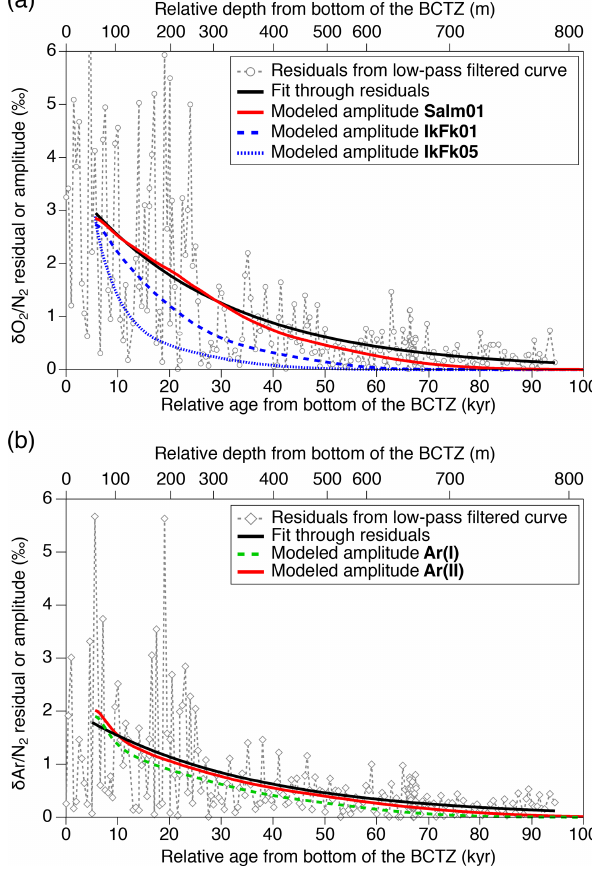
Figure 12. Diffusive smoothing of (a) δ O 2 / N 2 and (b) δ Ar / N 2 below the BCTZ. Open markers with dashed lines (gray) are the residuals from the low-pass-filtered data. Black lines are exponen- tial fits through the residuals for > 5600 years (corresponding to the model’s initial age). The model results (standard deviations of 11cm resampled outputs) with the best permeation parameters are shown by solid red lines. Blue and green lines are the other model